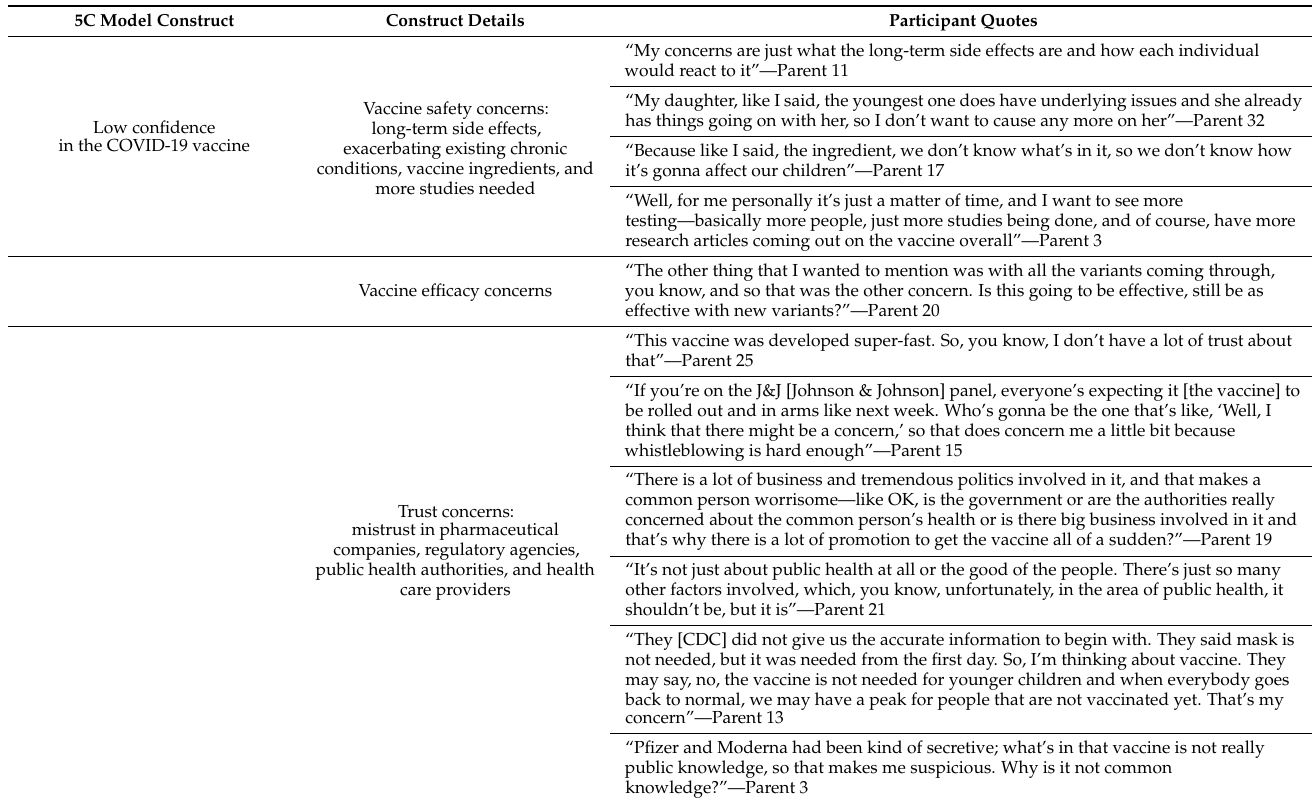
Table 4. Uncertainty in Vaccine